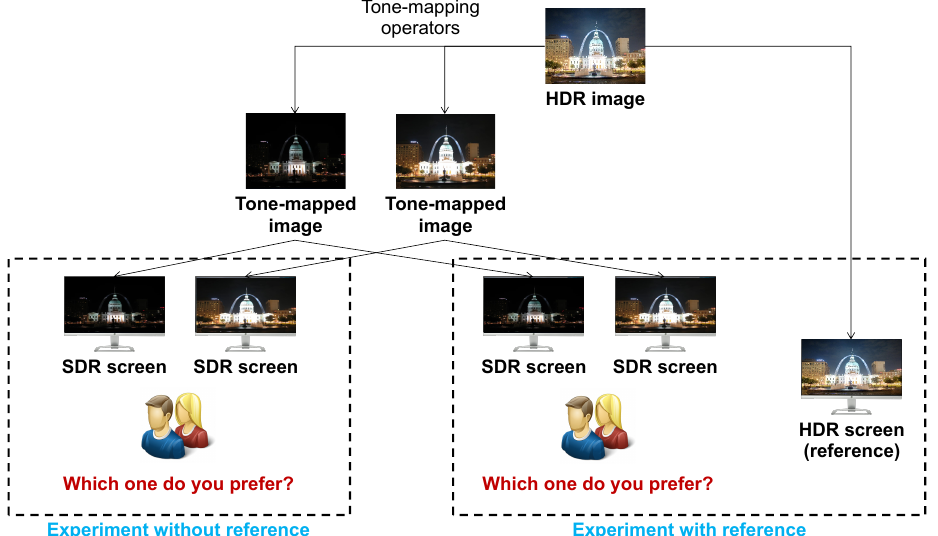
Figure 12. Process of estimating the correlation between IQ and IA and between IQ and IN.